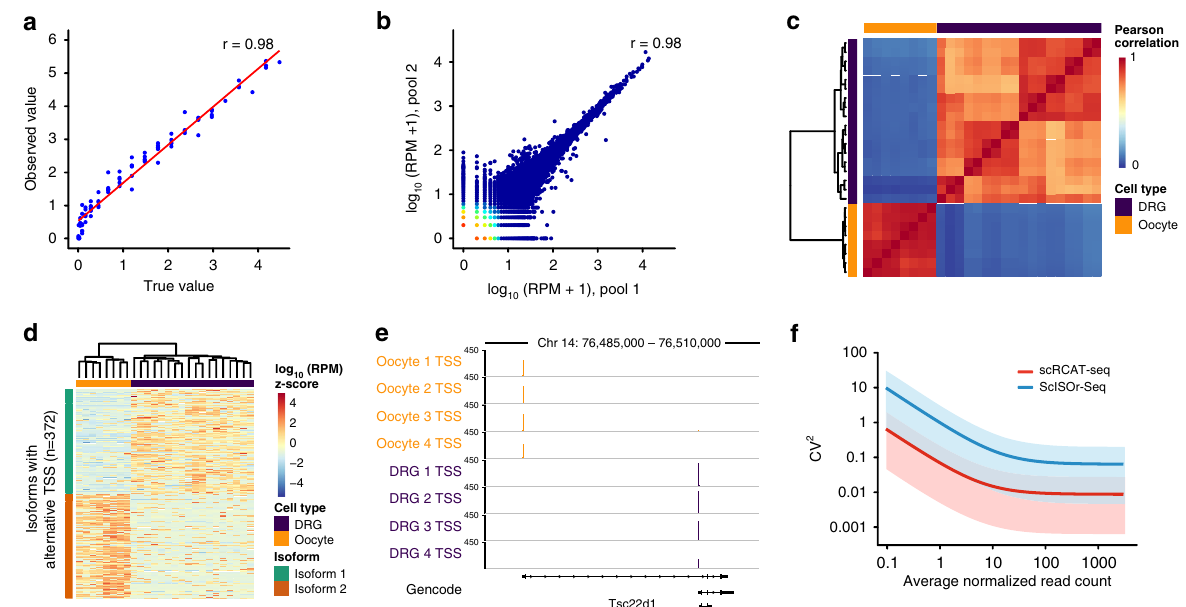
Fig. 3 Quanti fi cation of RNA isoforms with alternative TSSs and TESs. a Scatterplot of observed transcript expression levels ( y -axis) and true abundance ( x -axis) of ERCC spike-ins through 5 ′ -end quanti fi cation ( n = 92). Each point represents a transcript. The Pearson ’ s correlation coef fi cient is shown in the upper right corner. b Scatterplot shows the Pearson ’ s correlation of transcriptional level of isoforms between replicated pools of three single cells. c Heatmap for Pearson ’ s correlation coef fi cient of transcriptomes of DRG neuron and oocytes, based on 5 ′ -end quanti fi cation of RNA isoforms. d Heatmap showing RNA isoforms of alternative TSS choices with cell-type speci fi city. The major isoforms either in oocytes or in DRG neurons are shown ( n = 372 isoforms). e Genome browser tracks showing the alternative choices of TSS of Tse22d1 between oocytes and DRG neurons. f Squared coef fi cients of variation of scRCAT-seq ( n = 4) and ScISOr-seq ( n = 4), versus the means of normalized read counts. Shown is the mean of squared coef fi cients of variation shaded by 95% con fi dence intervals. Source data are provided as a Source data fi (Supplementary Fig. 8e). Major TSSs/TESs of the cells at each